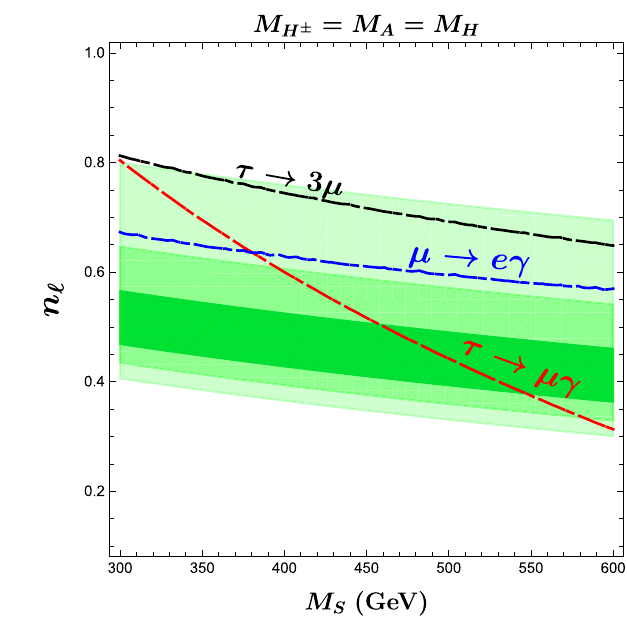
Fig. 2 Asimultaneousexplanationof R D and R D ∗ anomaliesisshown in red with 1 σ (darker) and 2 σ (lighter) experimental errors, respec- tively.Theregionsbelowtheblackandbluecurvesarealreadyexcluded by B ( B c → τν) > 30%, B ( B c → τν) > 60%, and F D ∗ The gray region is excluded by B ( B → X s γ) , while the 2 σ range allowed by (cid:16) M exp s /(cid:16) M SM s is indicated by the green region